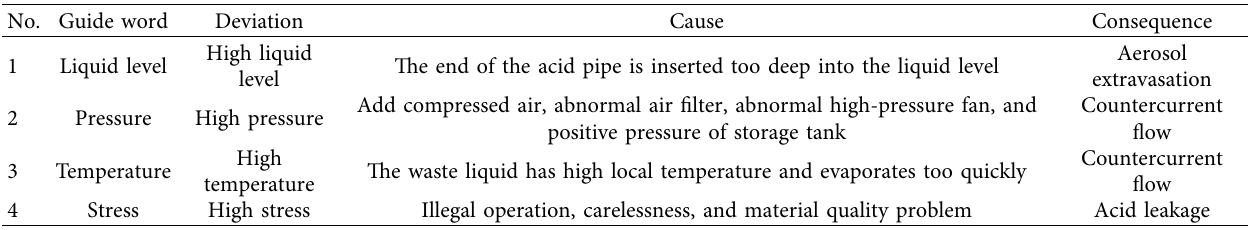
Table 2: HAZOP analysis table.